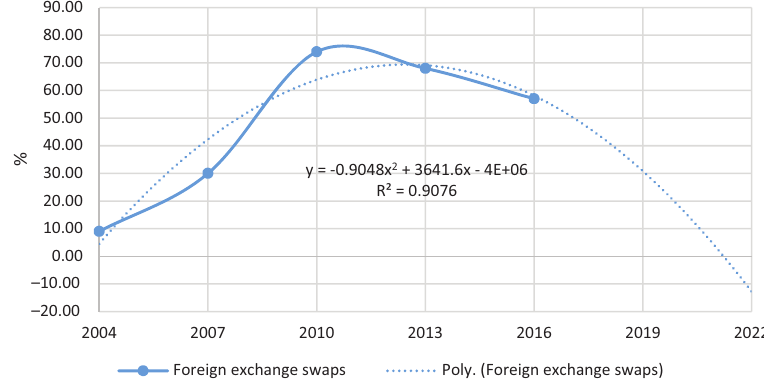
Figure 10. Forecast of FX swaps based on factual data and applying a polynomial function (source: developed by the authors based on LB, 2016, 2018, 2019b; BIS, 2018a, 2018b)